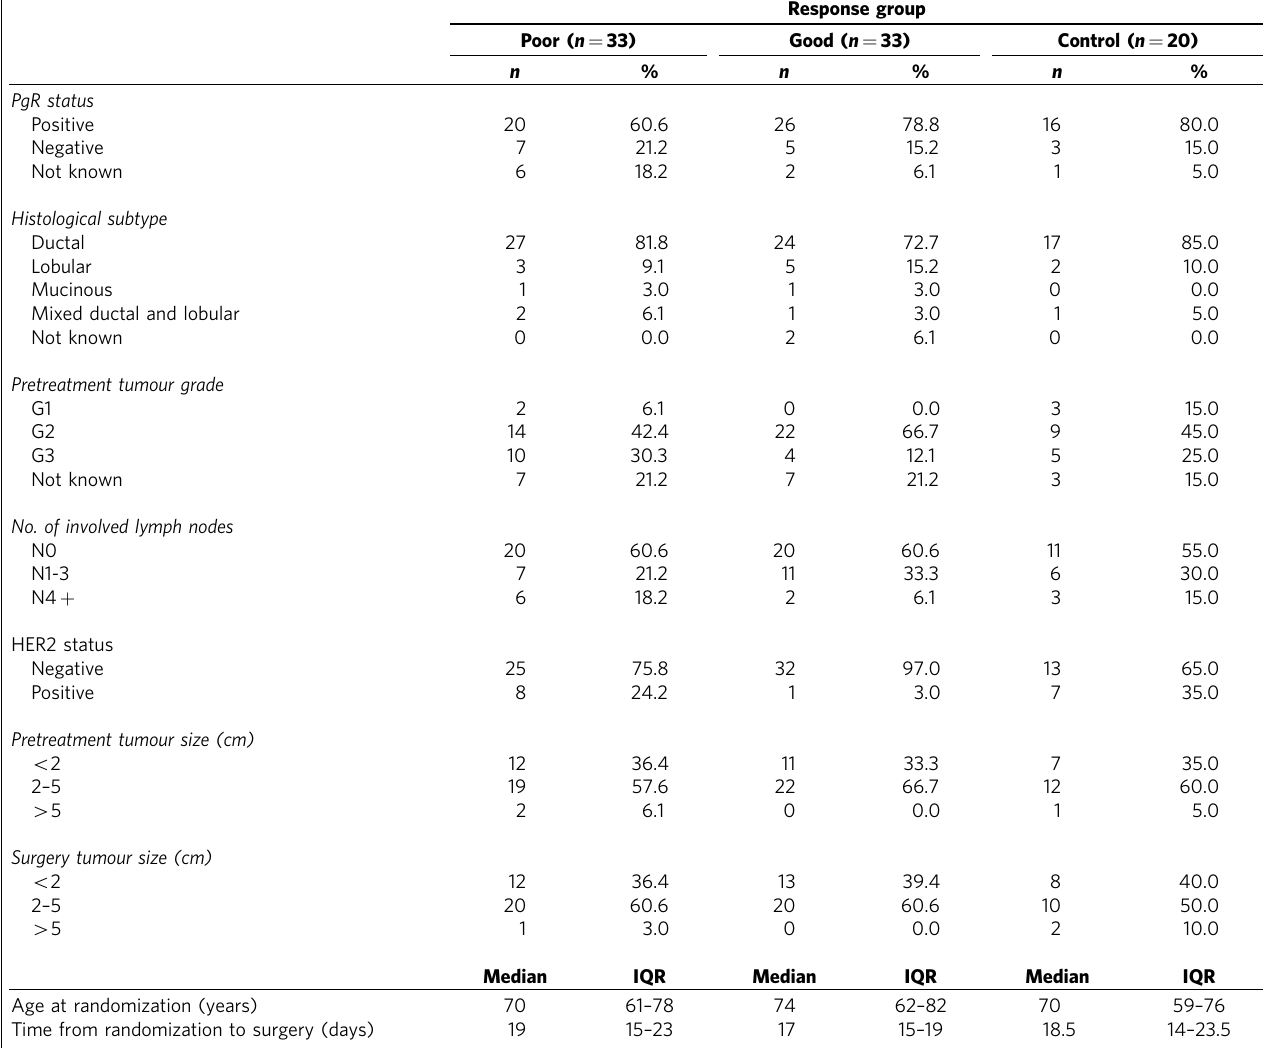
Table 1 | Clinical data summary of all 86 patients in this study.